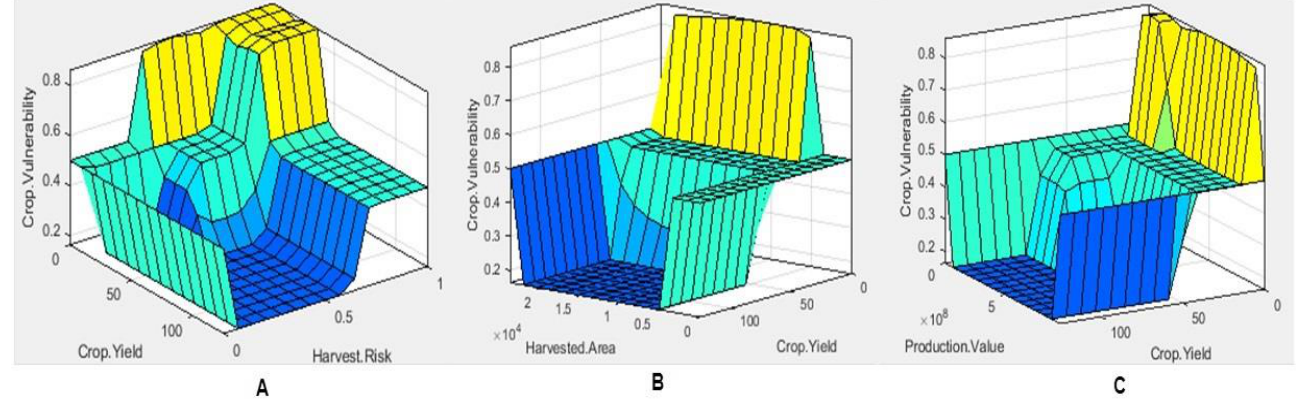
Figure 11. Impact of input variables in crop vulnerability model.